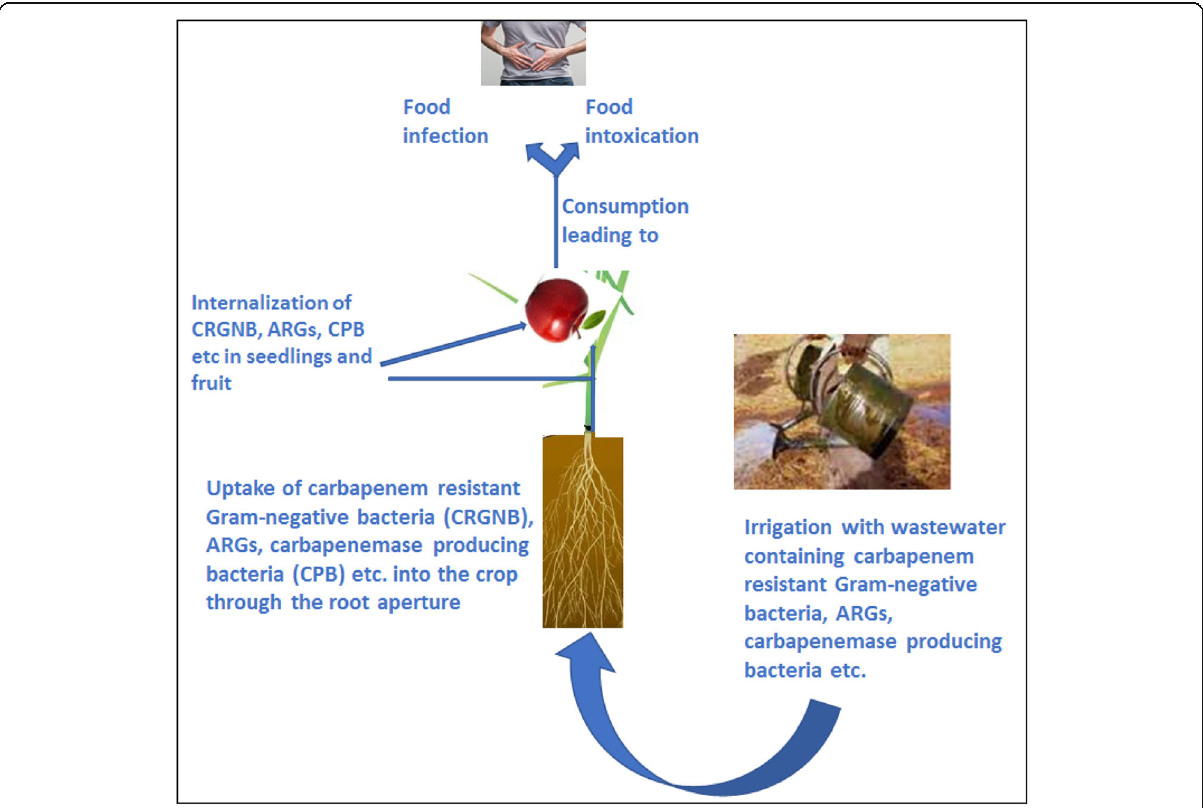
Fig. 2 Uptake and internalization of carbapenem-resistant Gram-negative bacteria (CRGNB), ARGs, carbapenemase-producing bacteria (CPB) etc. into edible